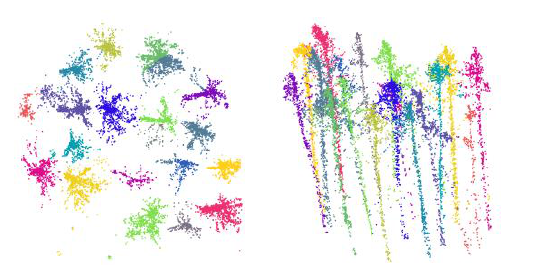
Figure 1. Top and the front of Plot A segmented using Method 2 (calibrated), with each separate tree assigned a random colour.